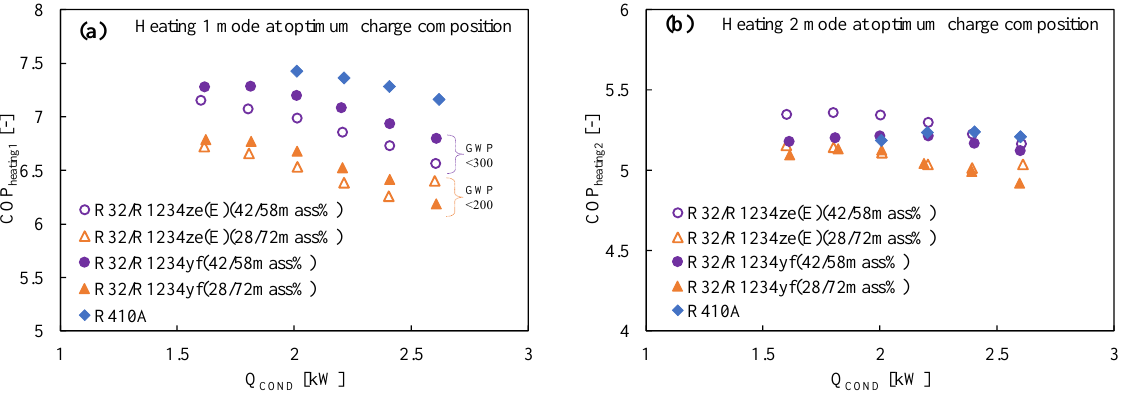
Figure 6. Comparison of the COP with the heating load at the optimum charge condition in ( a ) heating mode 1, ( b ) heating mode 2 (for modes 1 and 2, the condenser water inlet – outlet temperatures were 20 → 30 and 20 → 45, respectively, while the evaporator water inlet – outlet temperatures were constant at 15 → 9) [59].